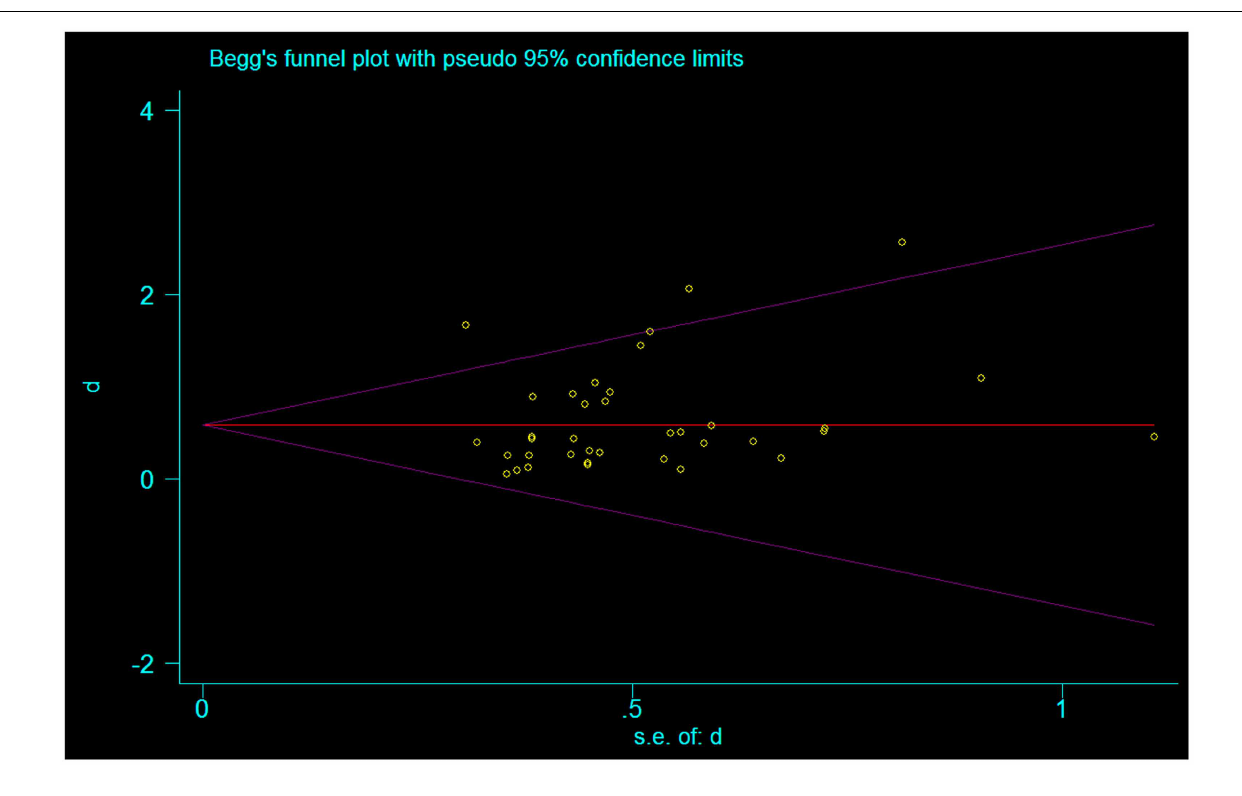
FIGURE 3 | Funnel plot representing publication bias assessment of the effect sizes (Cohen’s d ) by accounting for their standard errors. The pooled effect size is represented by the horizontal solid line.